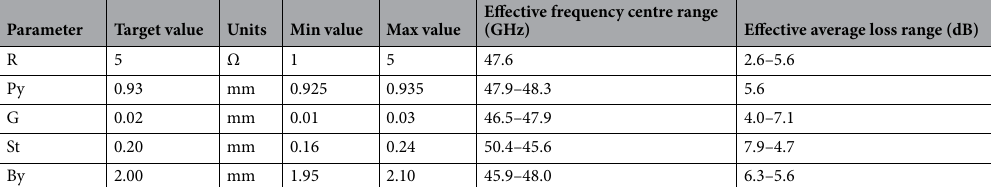
Table 3. Structures sensitivity study. Sensitivity study of the effect of key parameters on the performance of the structure.